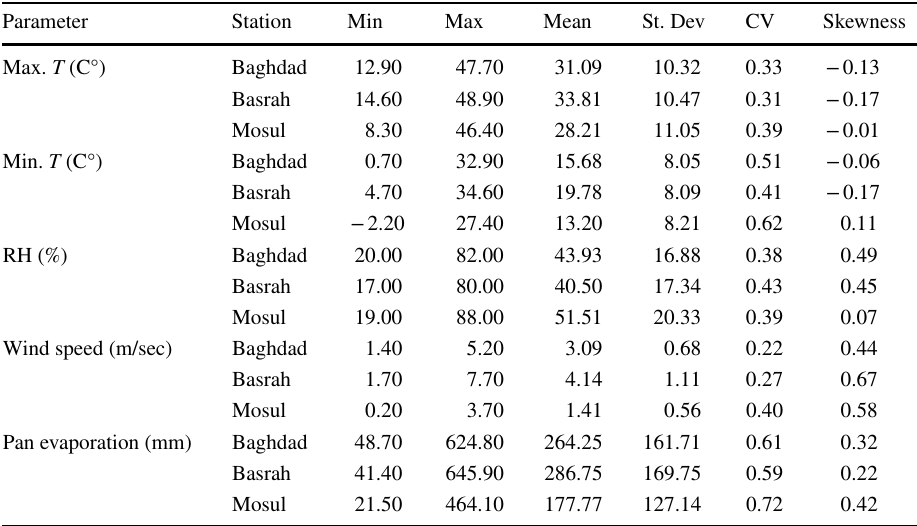
Table 1 Statistics of the measured meteorological parameters at study areas